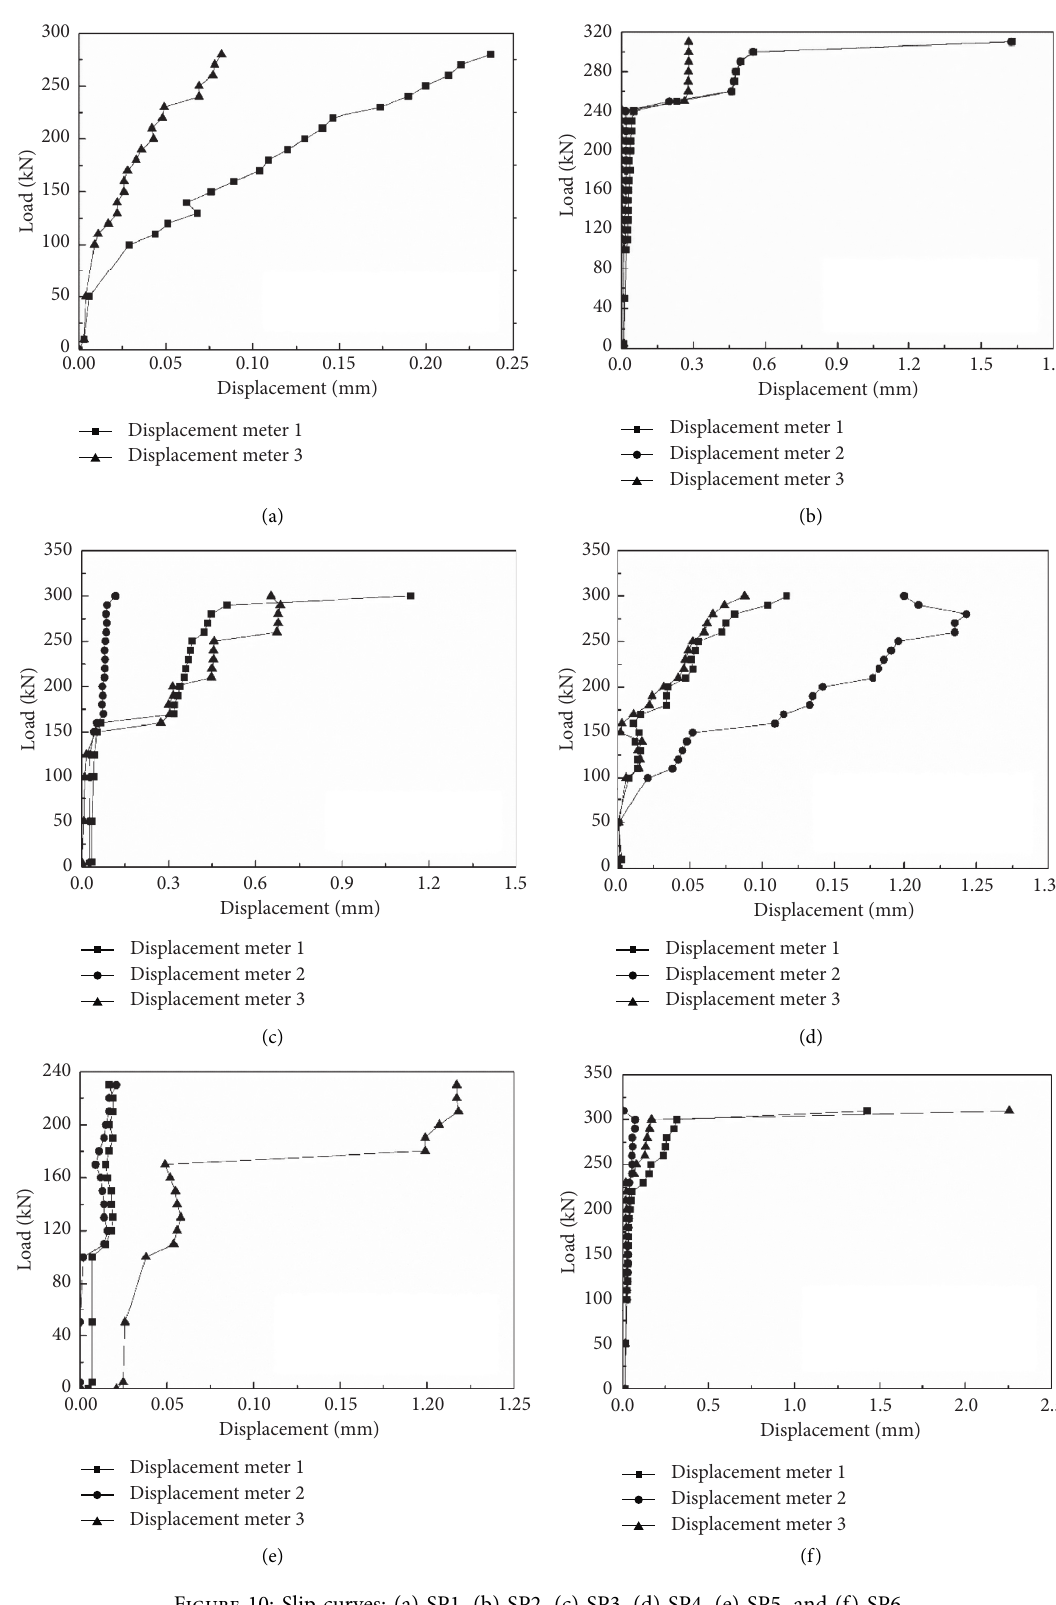
Figure 10: Slip curves: (a) SP1, (b) SP2, (c) SP3, (d) SP4, (e) SP5, and (f)